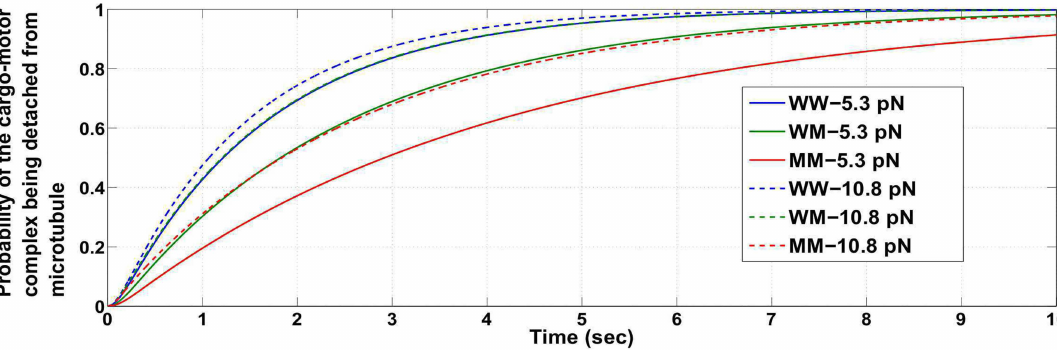
Fig 4. Probability of the cargo-motor complex getting detached from the microtubule, for ensembles WW, WM and MM at load forces close to but less than F s and 2 F s ( F s = 5.5 pN